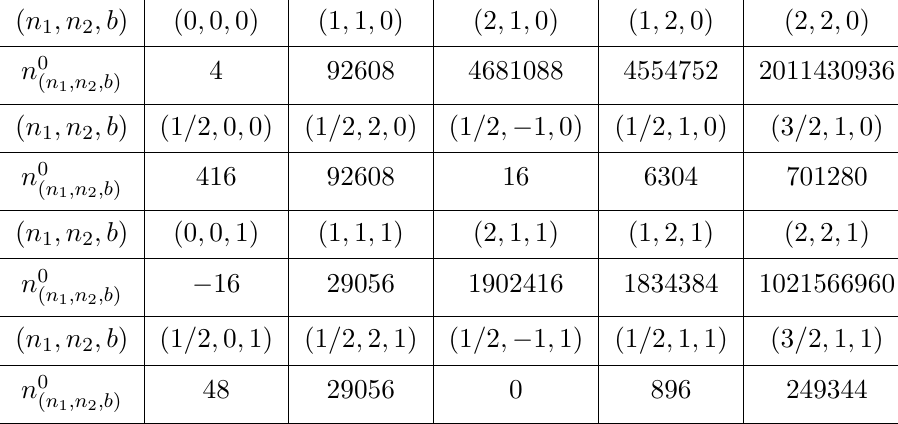
Table 6 . 2 A orbifold, non-standard embedding, with single Wilson line. Shift is given by, (cid:13) =